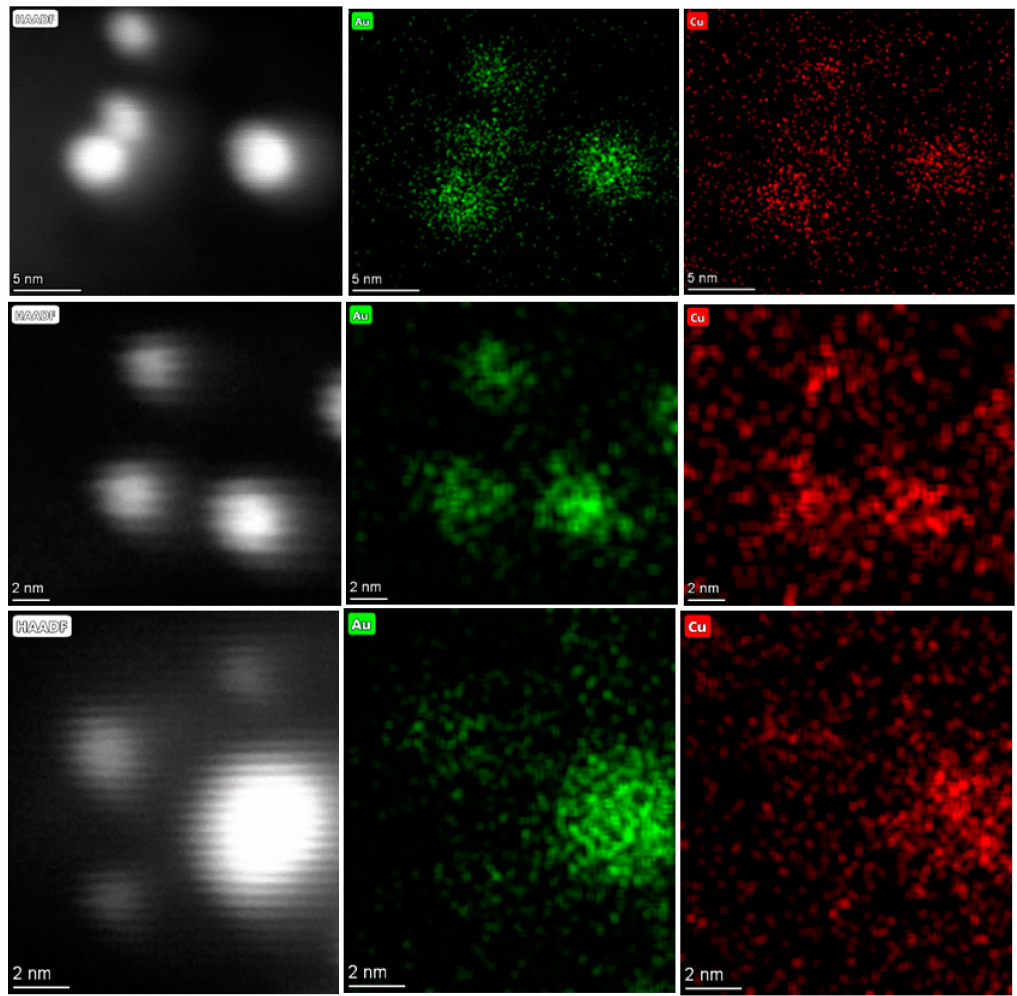
Figure 2. High angular annular dark field (HAADF) images with Au and Cu elemental maps (background corrected and fit Au-L and Cu-K intensities, respectively) recorded during the STEM-EDS measurement of Au1Cu1 sol.